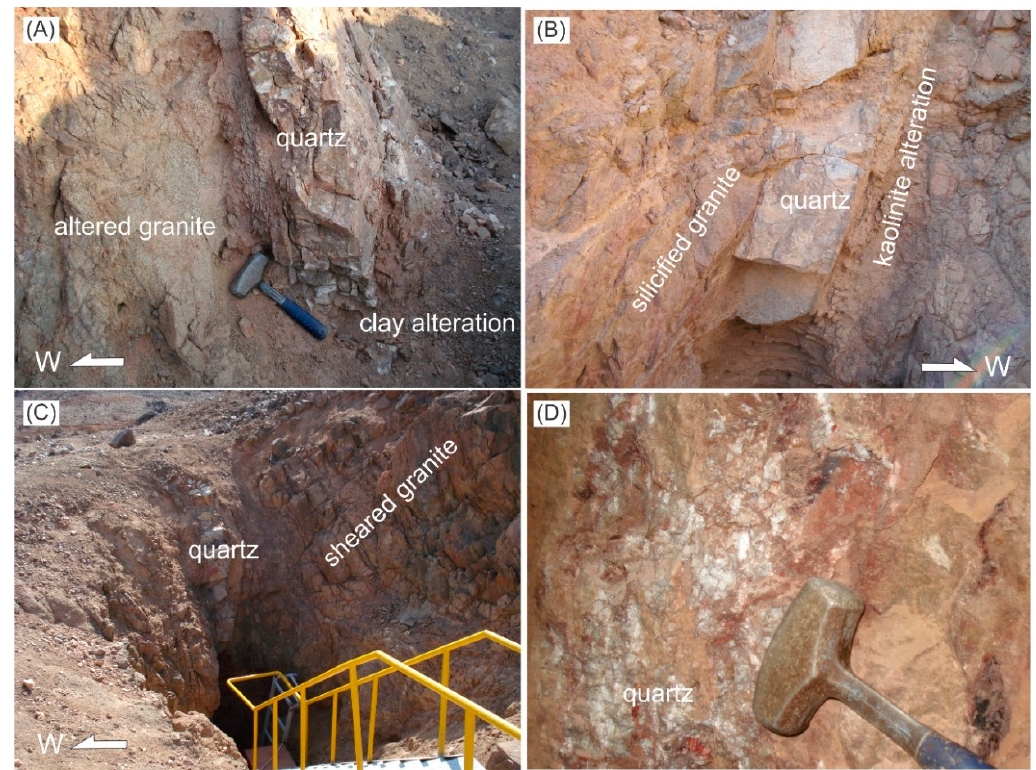
Figure 16. Field relationships of the orebodies at the Samut mine area showing: ( A ), ( B ), ( C ) Mineralized quartz veins at the Samut mine area, commonly associated with sericite, kaolinite, and sulfide alteration. Notice that the alteration zones are of limited thickness (commonly <0.5 m-wide), ( D ) Brecciated quartz vein exposed in the underground mine levels with abundant wall rock material and disseminated pyrite and chalcopyrite, locally altered into malachite and limonite, respectively.